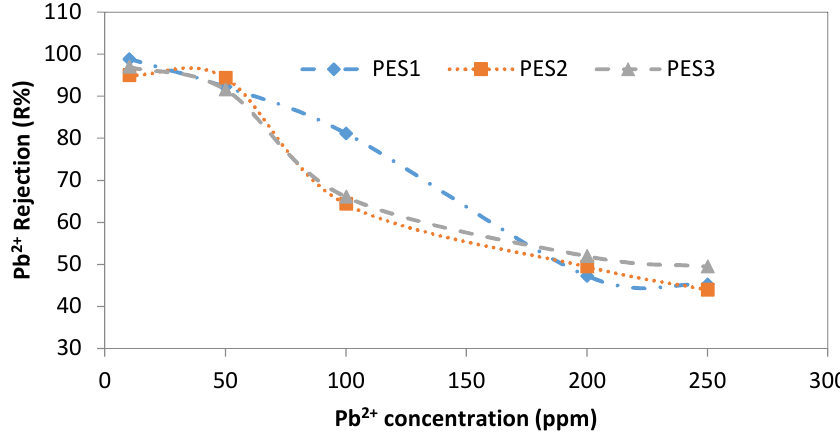
Figure 9. Effect of initial Pb 2+ concentration on Pb 2+ rejection using PES1, PES2, and PES3 membranes (experimental conditions: pH = 6 ± 0.2, transmembrane pressure of 1 bar).